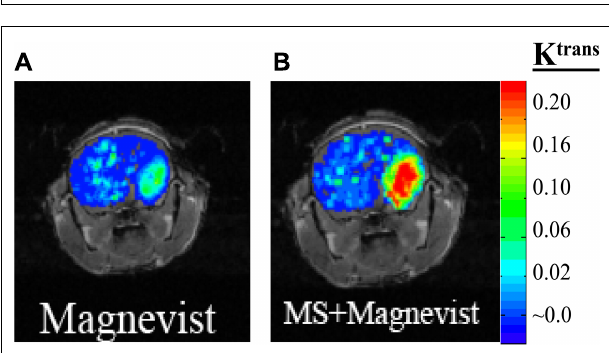
FIGURE 2 | Effect of NS-1619 on K trans showing the increased level of contrast enhancement in the NS-1619-treated rat as quantified by DCE-MRI analysis. The tumor volumes measured byT 1 -weighted images are approximately 38.94 and 44.10 mm 3 for the top and bottom frames, respectively.Tumor volumes were computed by manually outlining the enhancing region of the brain (for each slice) and multiplying the number of voxels within each ROI by the voxel size (0.273 mm 3 ).The increased level of enhancement in the treated rat was quantified by DCE-MRI analysis.The control group K trans mean was 1.83 ± 0.59/min, while the treatment group was 9.20 ± 7.69/min; this difference is significant at the P < 0.05 level.The control group v e mean was 0.16 ± 0.07, while the treatment group was 0.19 ± 0.07; this difference was not significant.